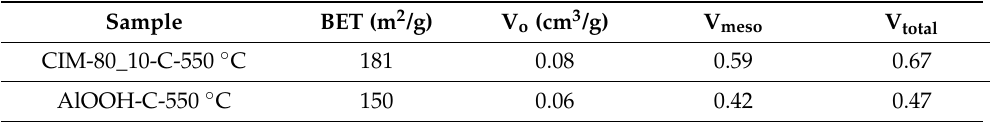
Figure 9. CIM-80_10-C-550 °C and AlO(OH)-C-550 °C samples: ( a ) X-ray diffraction patterns; ( b ) N 2 adsorption isotherms. Table 3. Textural properties obtained from N 2 adsorption isotherms of calcined samples.